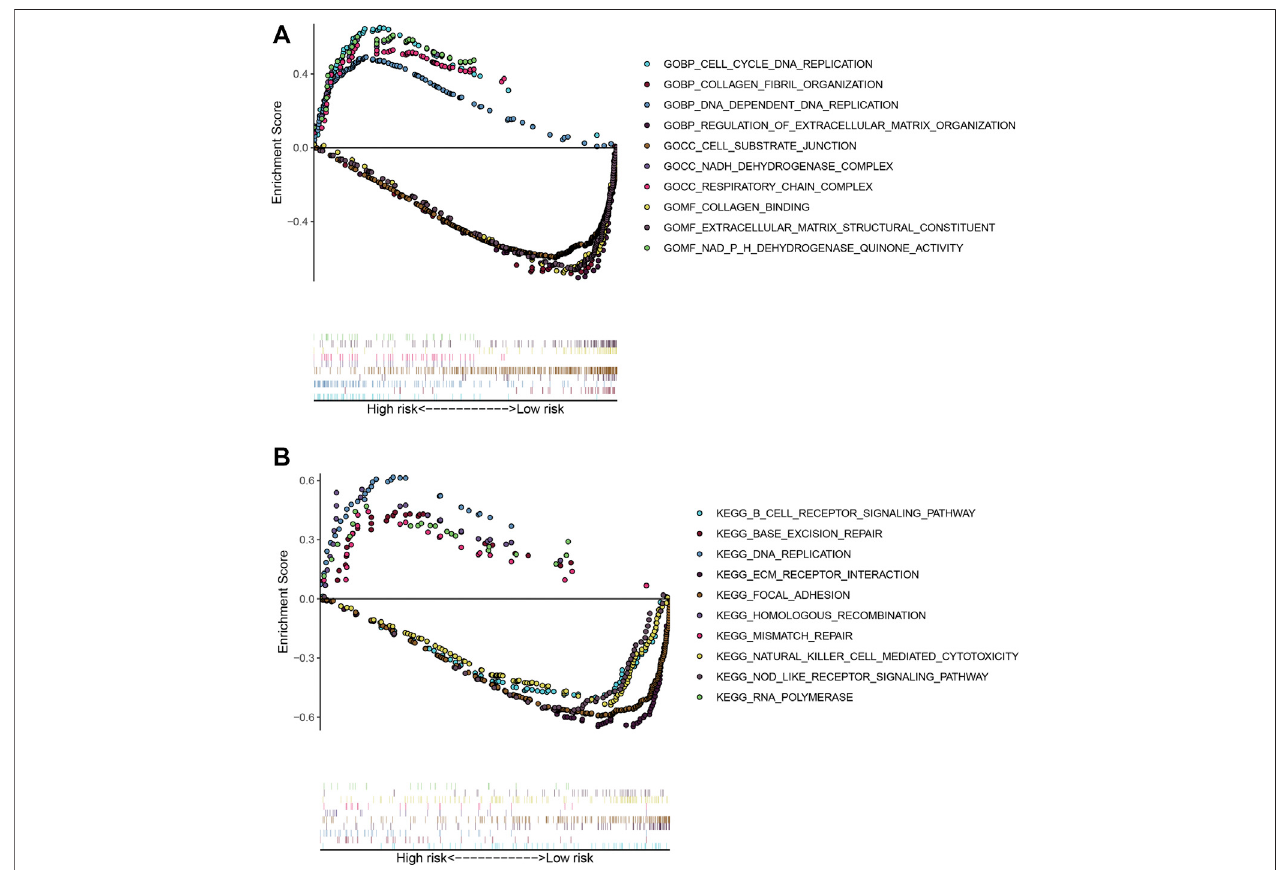
FIGURE 5 | Gene set enrichment analysis between the low- and high-risk subgroups. (A) Enriched GO terms between high- and low-risk groups. (B) Enriched KEGG pathways between high- and low-risk groups.